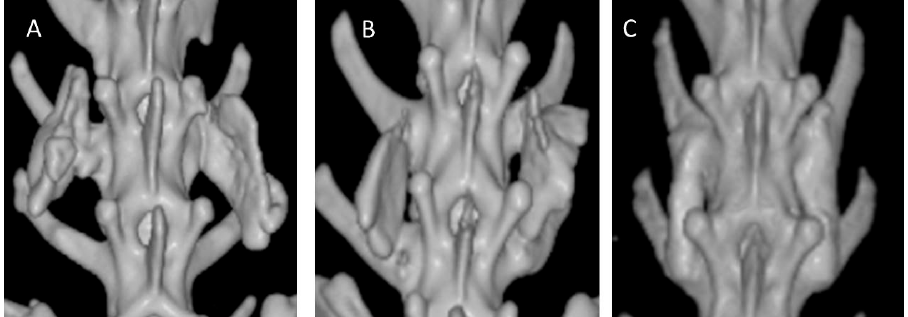
Figure 4. Computed tomography (CT) scans of 12-week specimens from each group. ( A ) collagen- β - TCP-HA; ( B ) collagen- β -TCP-HA/BMDMSCs; ( C ) collagen- β -TCP-HA/Baculo-BMP-7-BMDMSCs.